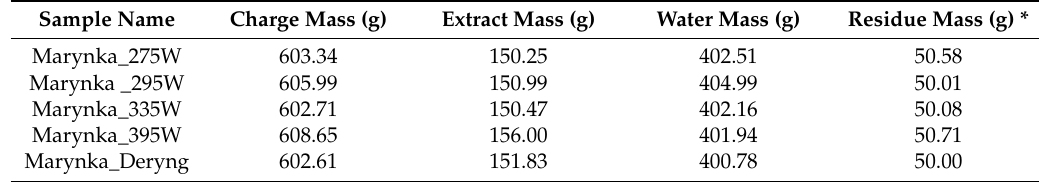
Table 1. Preparation of samples for Marynka